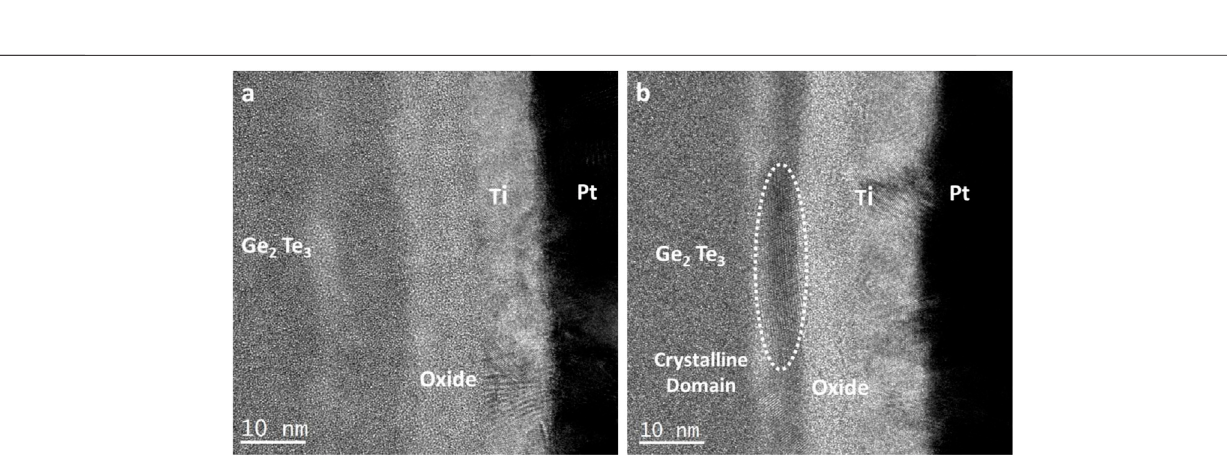
FIGURE 5 | HRTEM image of top dielectric/electrode interface showing (A) an amorphous structure in Ge 2 Te 3 prior to electrical biasing and (B) the presence of a crystalline domain in dielectric/ electrode interface after cyclic electrical biasing to HRS (enclosed in the dotted region).